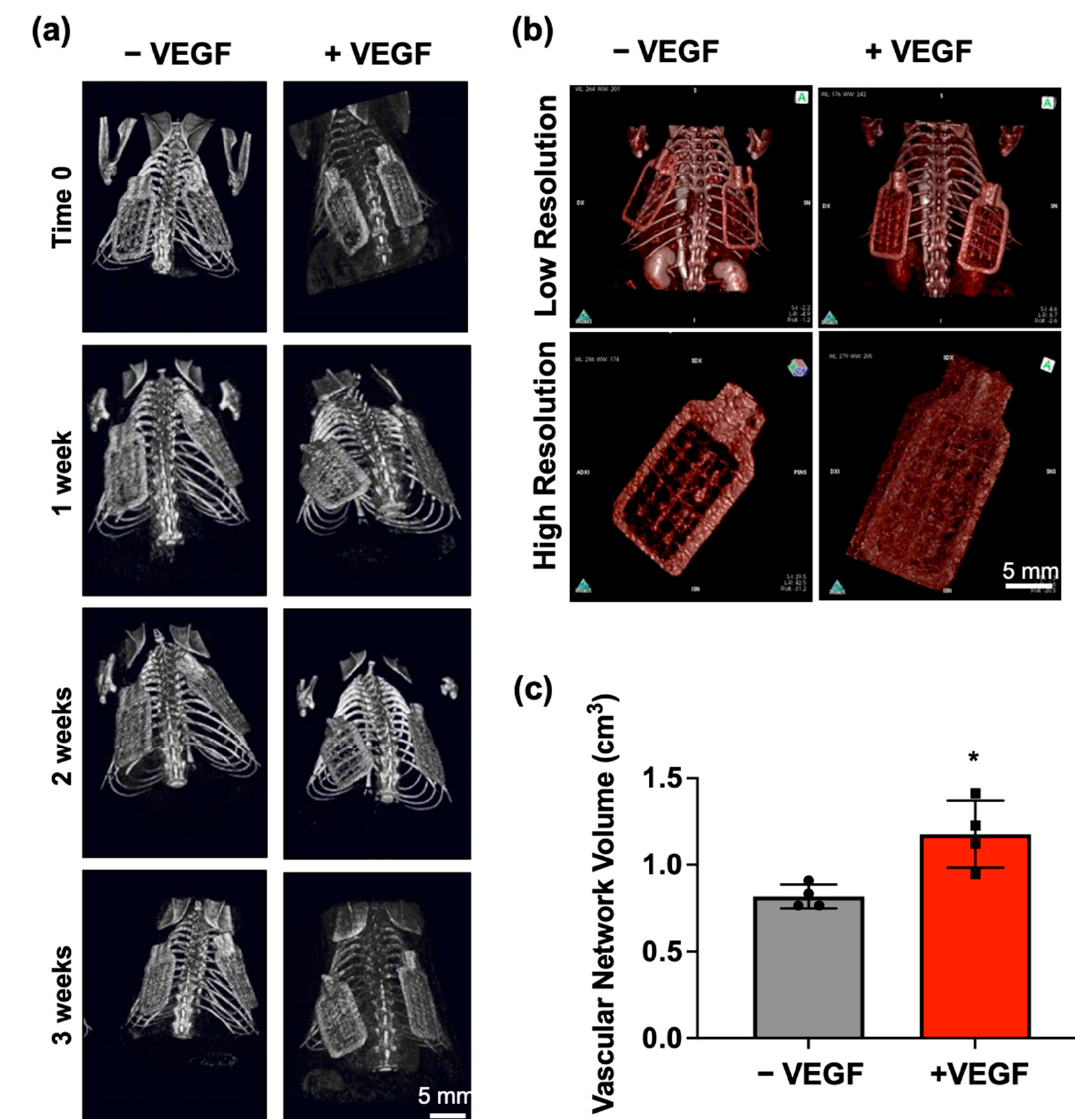
Figure 2. In vivo monitoring of device movement and evaluation of angiogenesis at 4 weeks. ( a ) Weekly representative micro-CT images enabling visualisation of implanted − VEGF and +VEGF macroencapsulation devices to accurately monitor movement over the 4-week period. ( b ) Representative images of Iopamiro ® 370 stained − VEGF and +VEGF devices were captured at both low (FOV73 camera) and high resolutions (FOV40 camera). ( c ) Mean volumes of surrounding vascular network estimated using the OsiriX lite program. n = 4 per group, data are represented as means ± SD, * p <